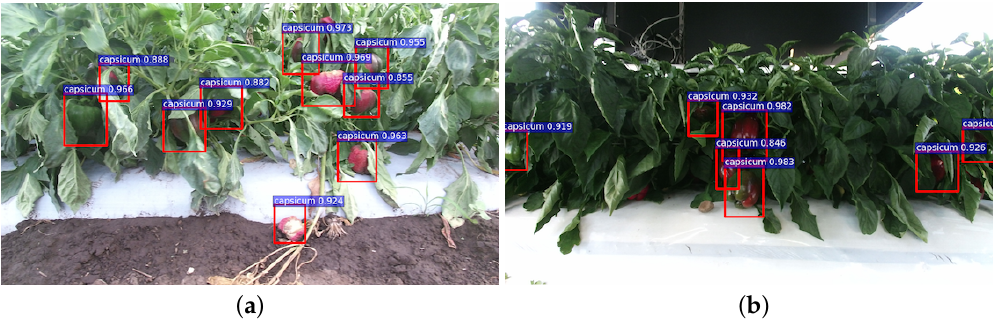
Figure 13. Instances of detection performance using a different camera setup (Kinect 2) and a different location. Above each detection is the classification confidence output from the DCNN. ( a , b ) Without/with a Sun screen shed, respectively. Despite the brightness being obviously different in the two scenes, the proposed algorithm impressively generalises well to this